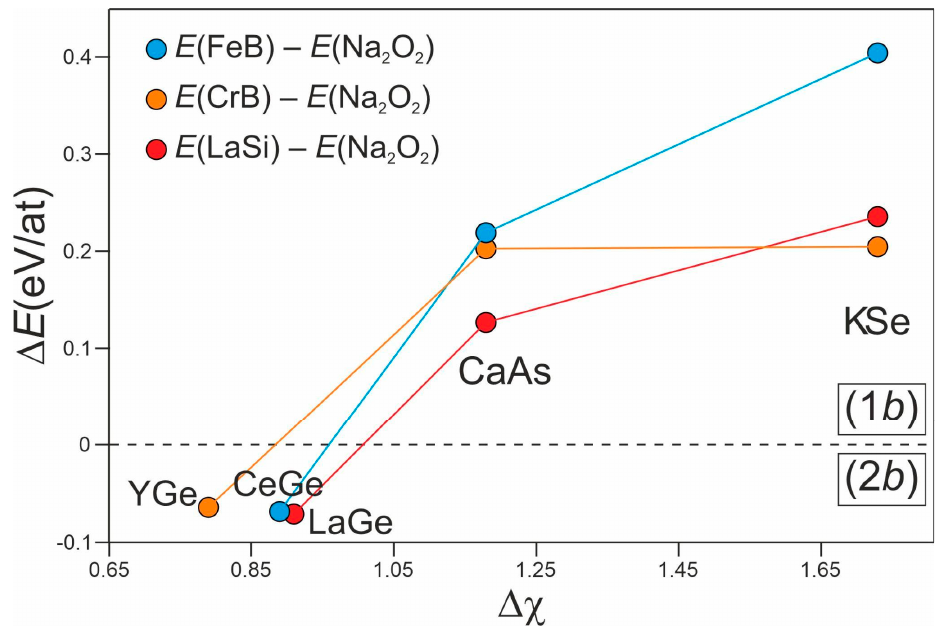
Figure 2. Energy difference ( Δ E ) as a function of the Pauling electronegativity difference ( Δ χ ) among the constituents of CeGe, YGe, LaGe, CaAs, and KSe. The dashed black line corresponds to Δ E = 0 and separates the stability region of (2 b ) polyanions, Δ E < 0, from that of the (1 b ) ones, Δ E > 0. Furthermore, the electronic density of states (DOS) for CeGe in the FeB, Li 2 O 2 , and Na 2 O 2 modifications have been calculated (see Figure 3) to give more insight into the chemical reasons behind these experimental and energetical outcomes.